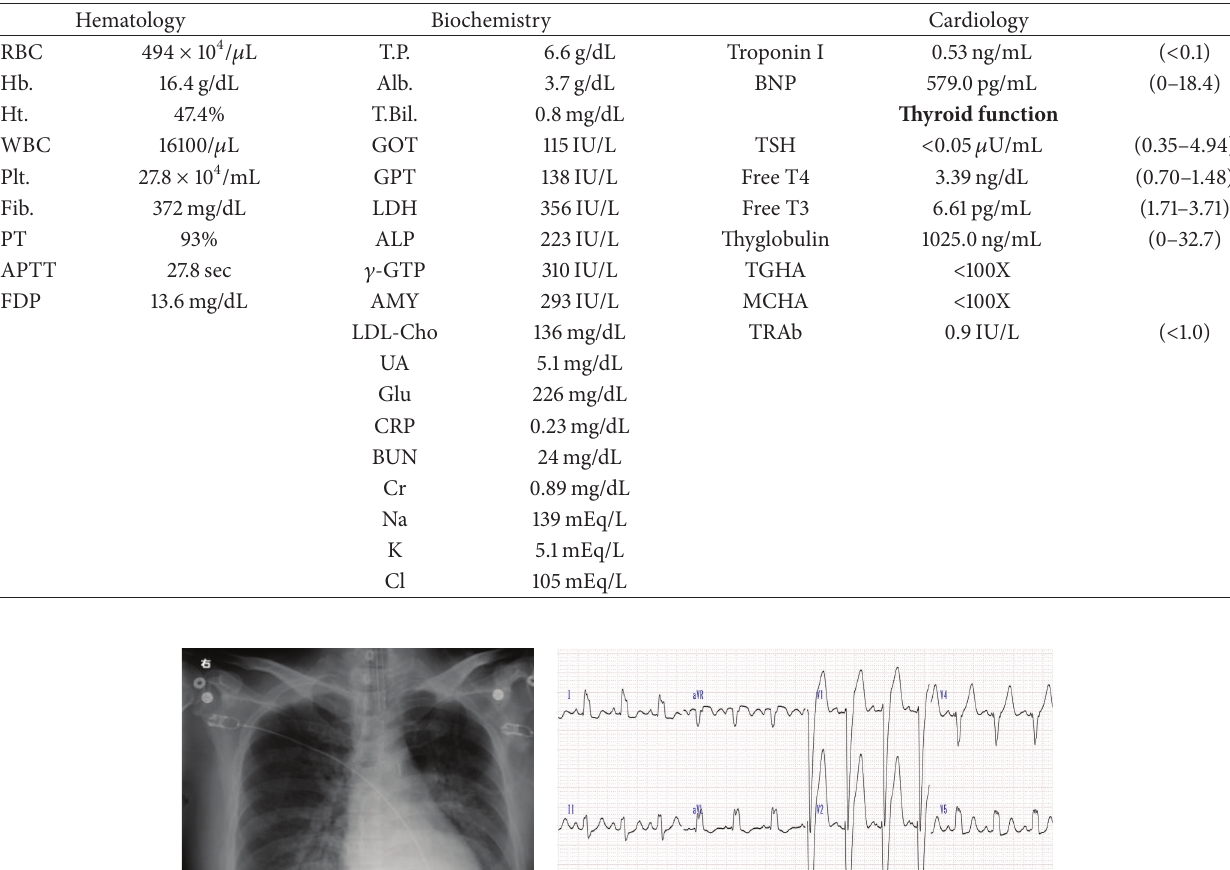
Table 1: Laboratory data on admission.